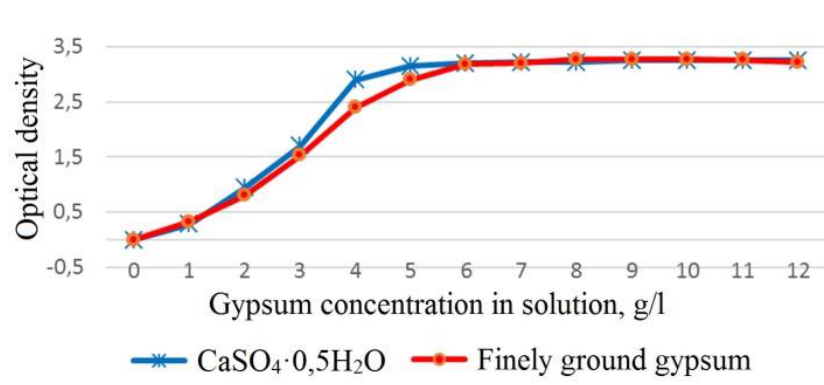
Figure 5. Changes in the optical density of gypsum mortars based on building gypsum and finely ground gypsum.